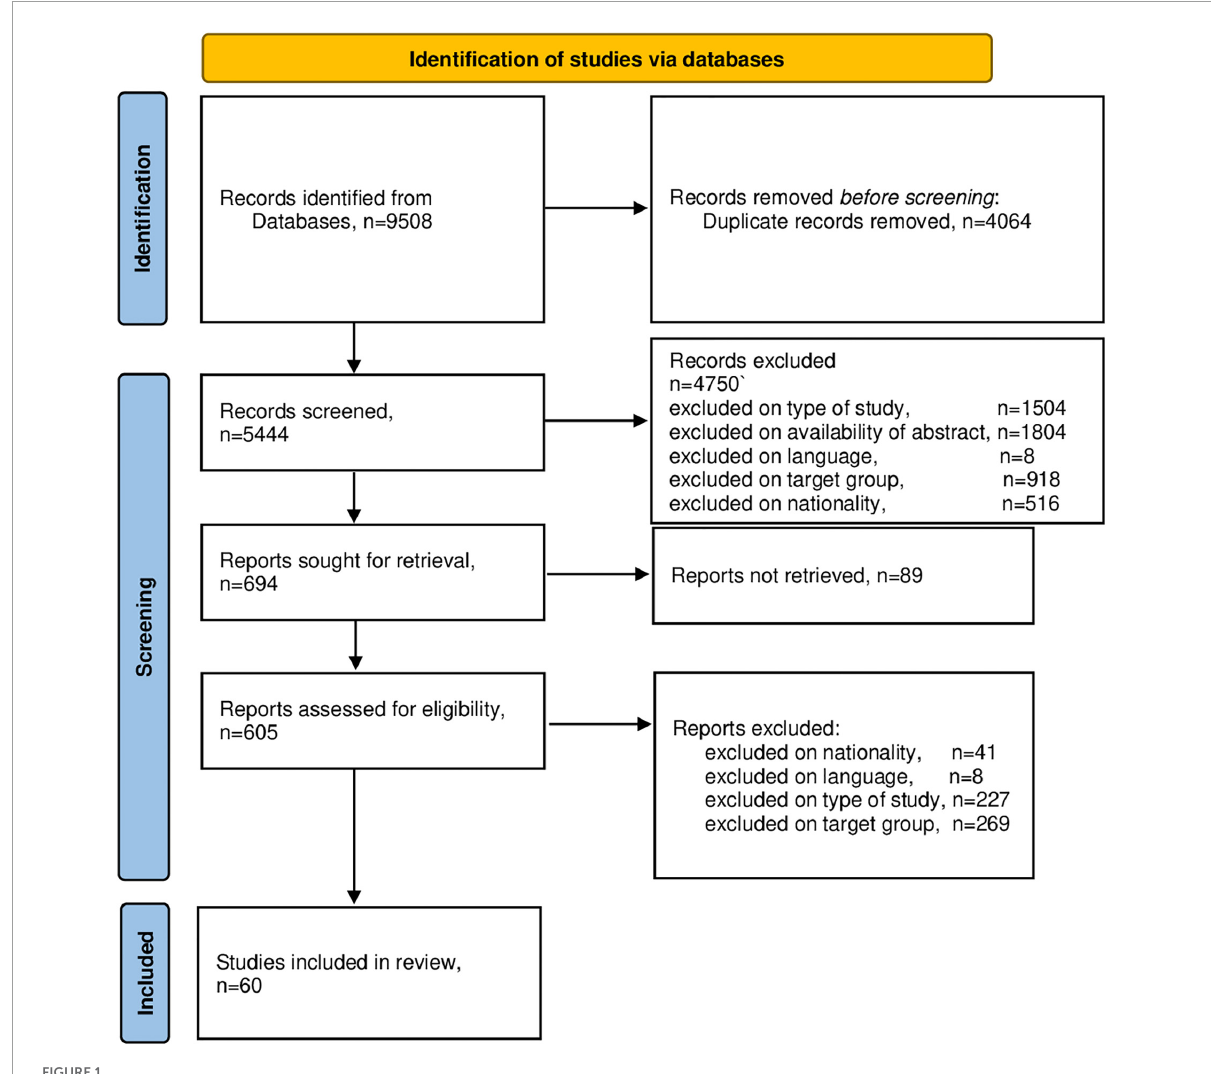
FIGURE1 PRISMA 2020 flow diagram. From: Page et al.